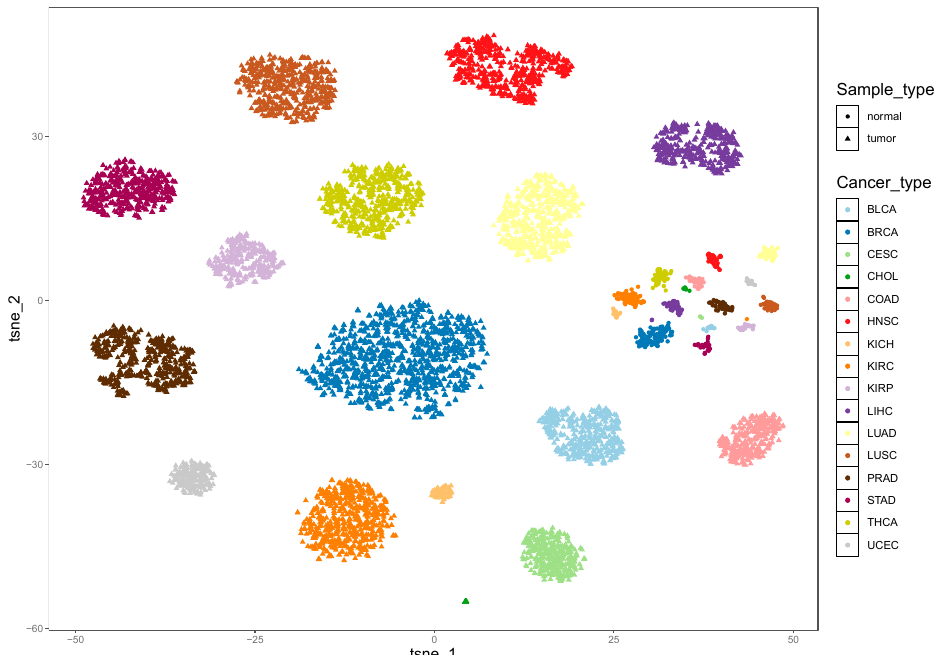
Figure 3. Results of the pan-cancer classification distributed in the t SNE plot. Di ff erent colors represent di ff erent cancer types and corresponding normal samples. The tringles and dots are used to distinguish tumor and normal samples. The number of clusters is 32, which contains 16 cancer types and their corresponding normal types.